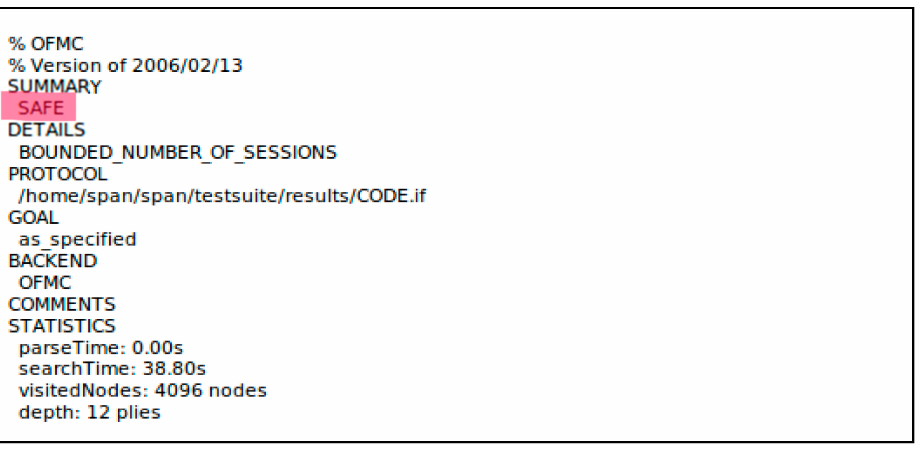
Figure 9. The results of the AVISPA simulation of the lightweight authentication MAC protocol for the CR-WSNs.